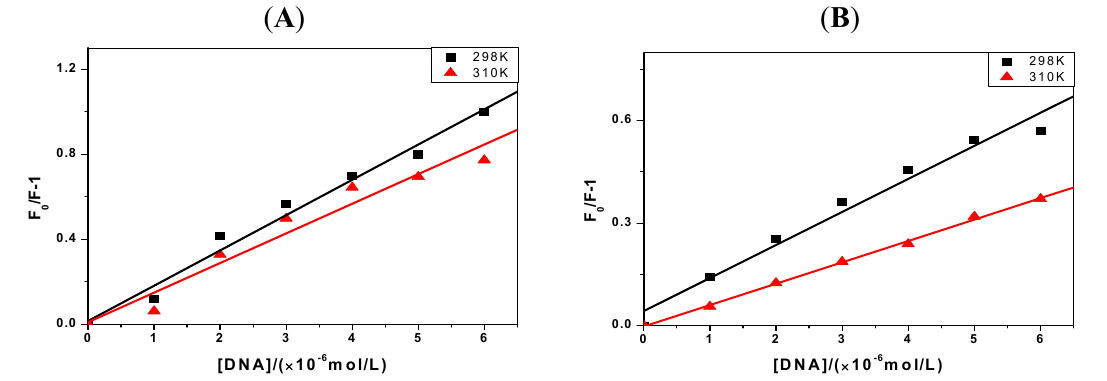
Figure 3. The Stern-Volmer plots of the fluorescence quenching of pyrene derivatives by C-myc DNA at 298 K and 310 K (the concentrations of pyrene derivatives are 1  mol/L, pH = 7.4). ( A ) 1-OHP and ( B )